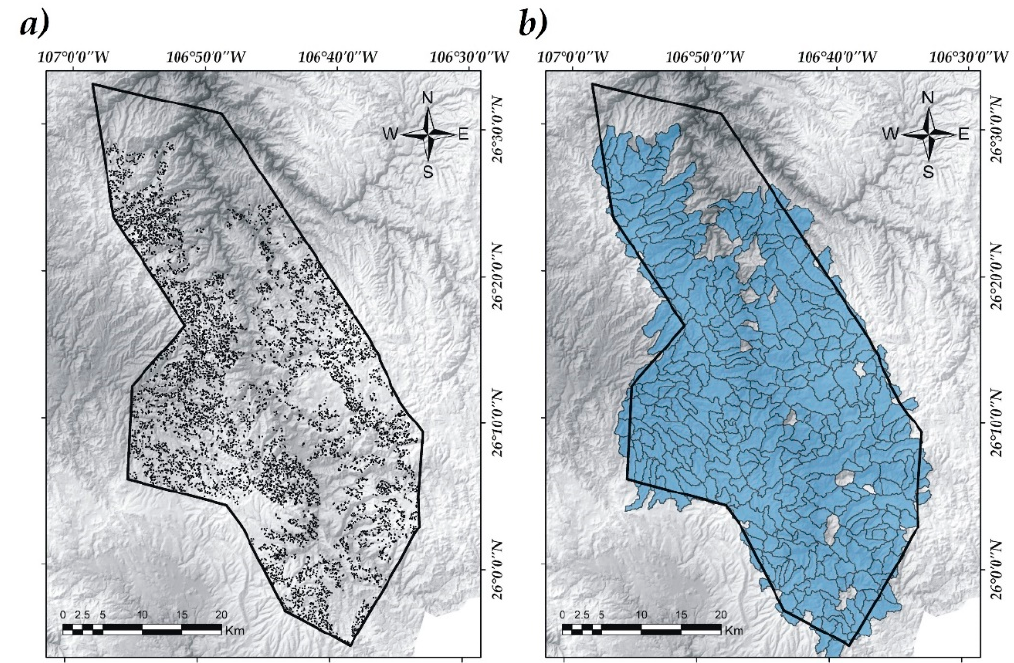
Figure 2. Sampling of structural variables of the forest ( a ), study unit: watershed ( b ).